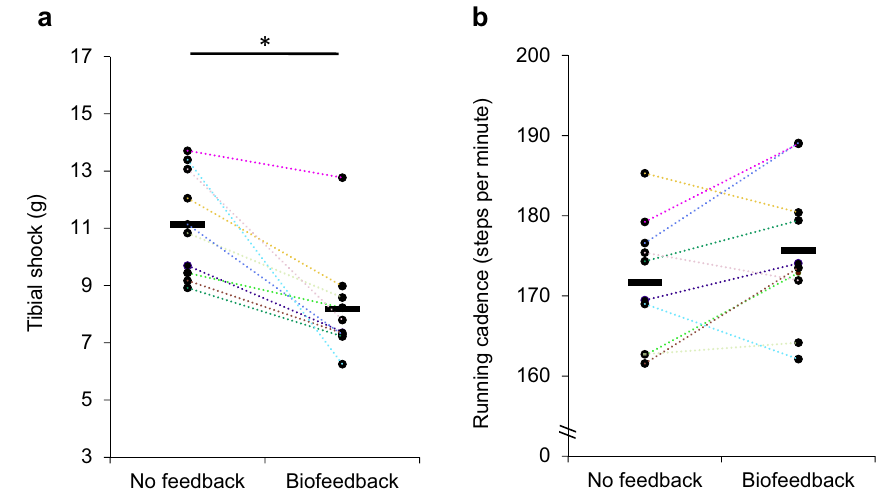
Figure 3. ( a ) The axial peak tibial acceleration representing the tibial shock and the ( b ) running cadence for the [left] no feedback and [right] biofeedback conditions. Every color is a different participant. The short horizontal line indicates the mean level of the variable of interest in a condition. * indicates p < 0.05.